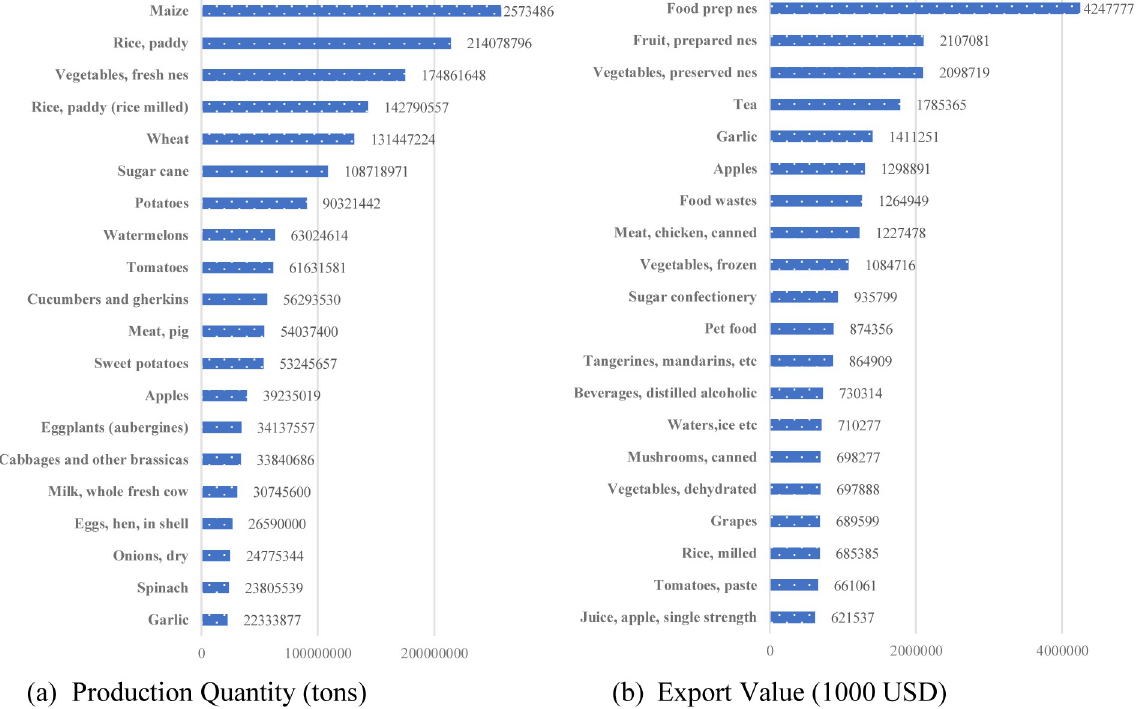
Fig 2. The production and exports of 20 main agricultural commodities of China in 2018. (a) Production Quality (tons), (B) Expert Value (1000